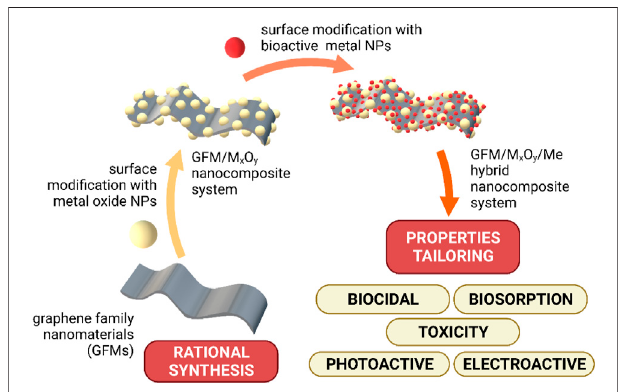
FIGURE 1 | Schematic of the areas of research covered by this